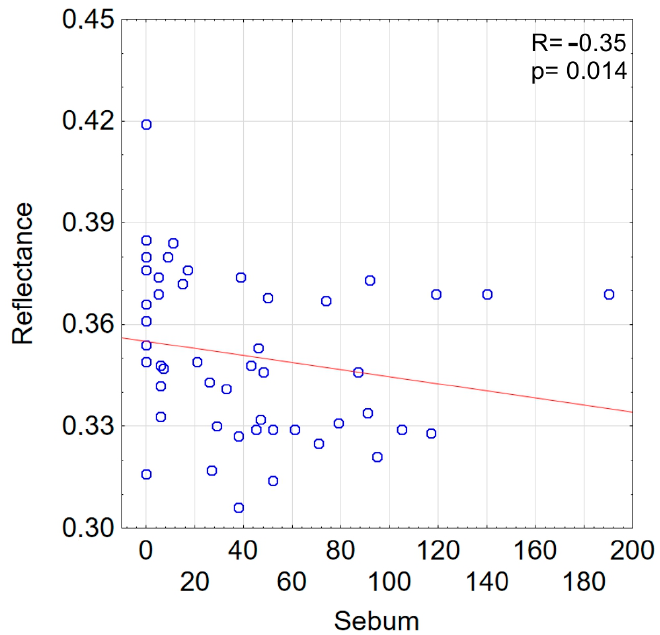
Figure 5. Correlation of sebum and skin reflectance at the wavelength 480–600 nm. Red line—trend line.